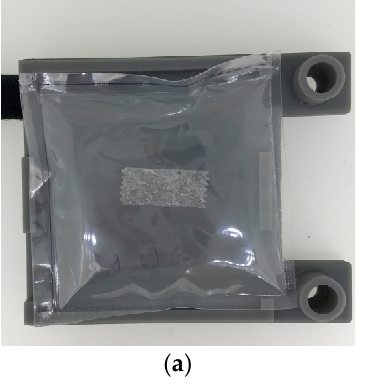
Figure 10. Three types of tested haptic gloves: ( a ) 1 liquid-pouch motor, ( b ) 2 motors and ( c ) 3 mo- tors.